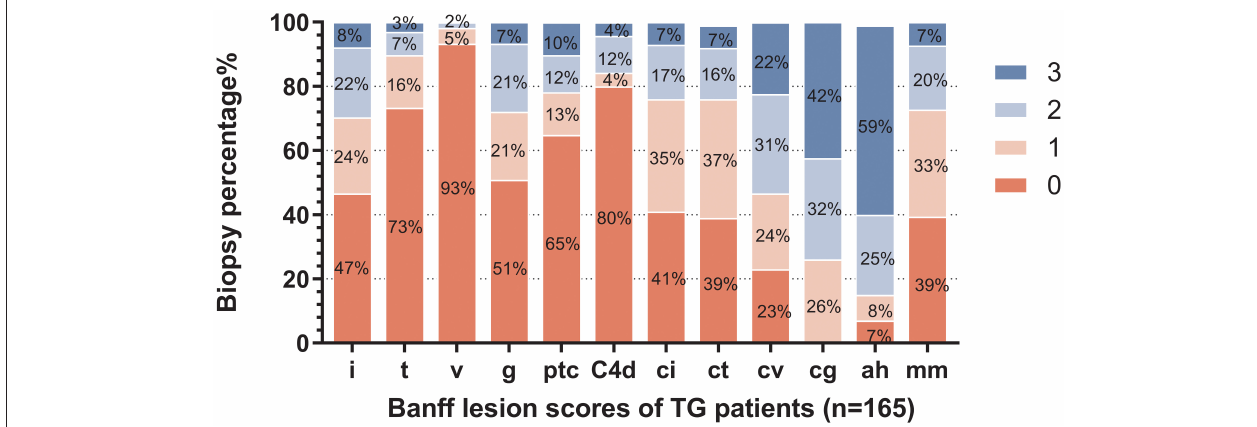
FIGURE 2 | Distribution of Banff lesion scores for enrolled patients. The stacked bar graph denoted the Banff lesion scores distribution and the percentages of corresponding histological changes degrees of all enrolled biopsies ( n = 165) in the study were shown. The abscissa scores represent I, interstitial inflammation; t, tubulitis; v, intimal arteritis; g, glomerulitis; ptc, peritubular capillaritis; C4d, endothelial cells C4d staining extent of peritubular capillary and medullary vasa recta; ci, interstitial fibrosis; ct, tubular atrophy; cv, vascular fibrous intimal thickening; cg, glomerular basement membrane double contours; ah, arteriolar hyalinosis; and mm, mesangial matrix